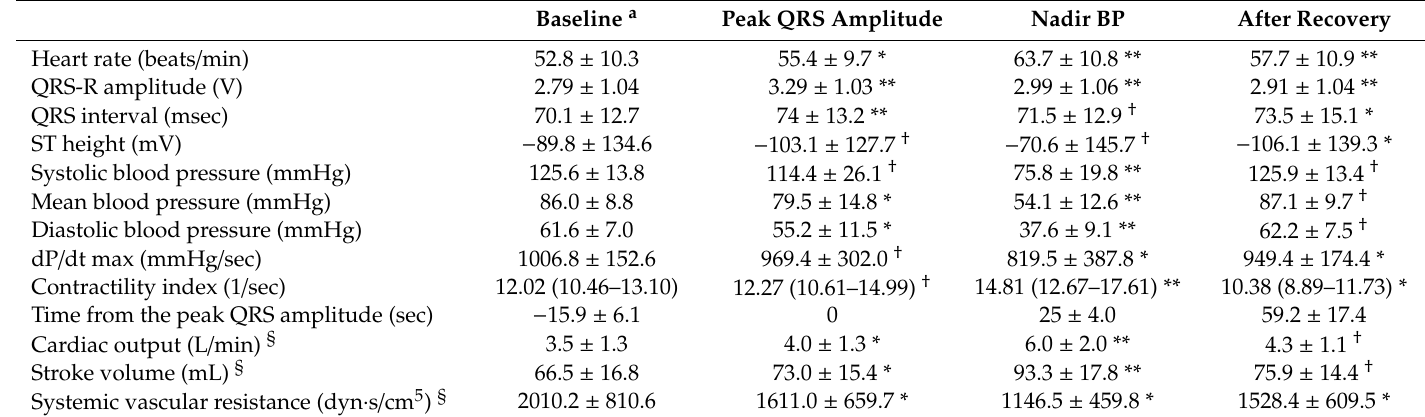
Table 2. Electrocardiogram and hemodynamic variables before, during, and after contrast-enhanced computed